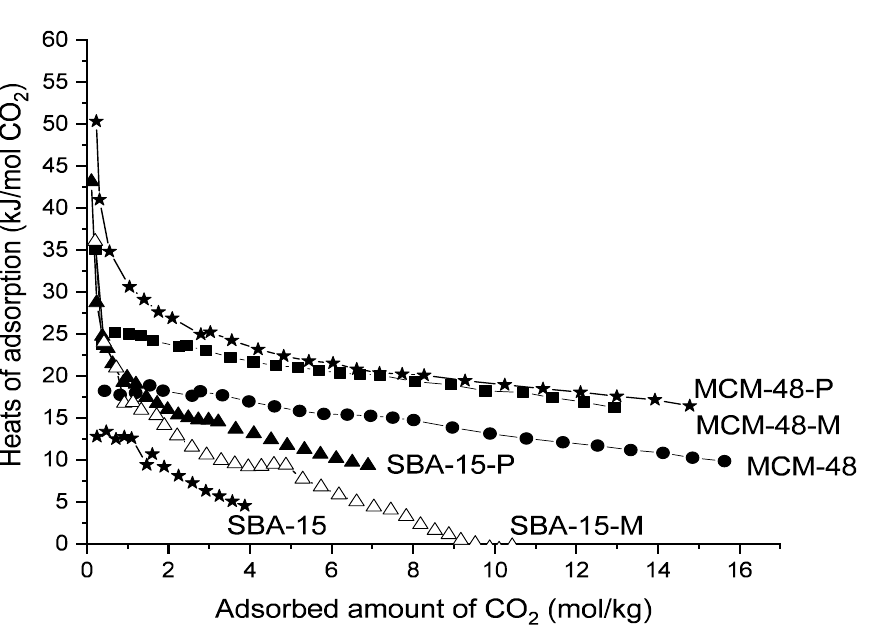
Figure 8. Heats of adsorption for the studied